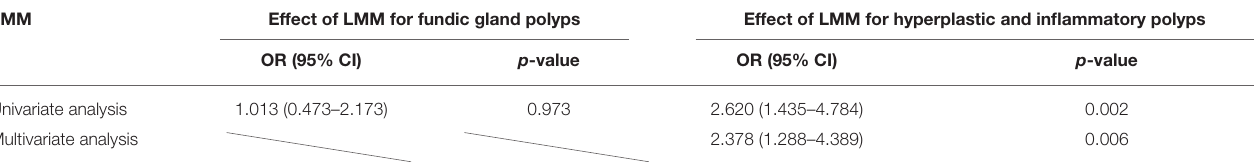
TABLE 4 | Logistic Regression Analyses for the different histologic types in gastric polyps. LMM